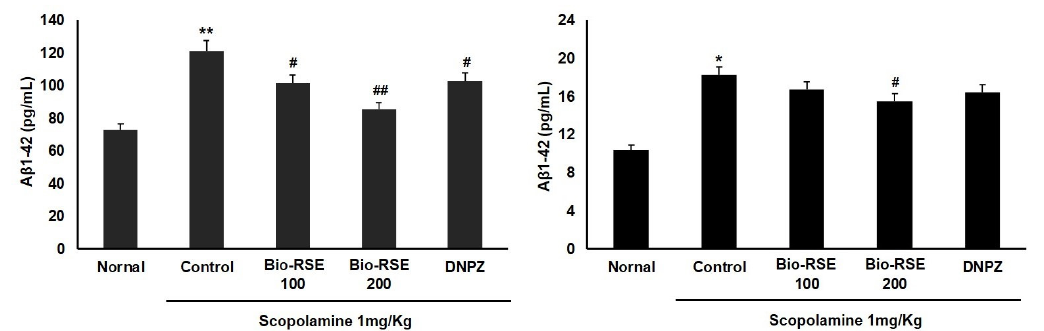
Figure 5. Effect of Bio ‐ RSE on A β 1–42 levels in serum and brain tissue. Values are the mean ±